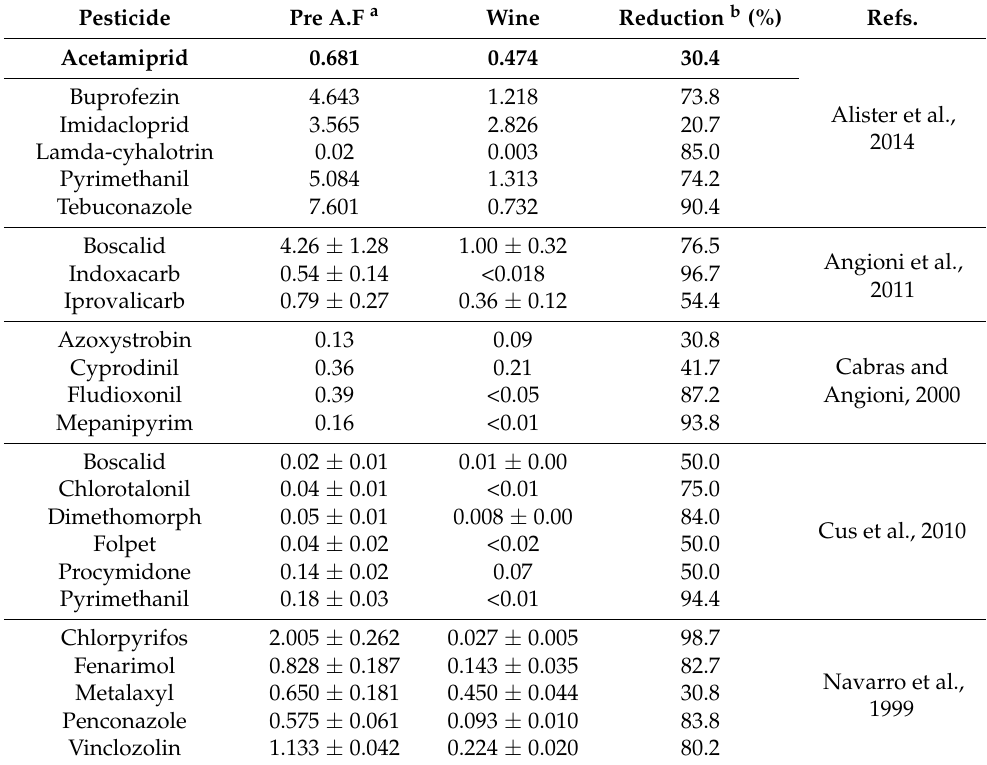
Table 2. Pesticide residues in